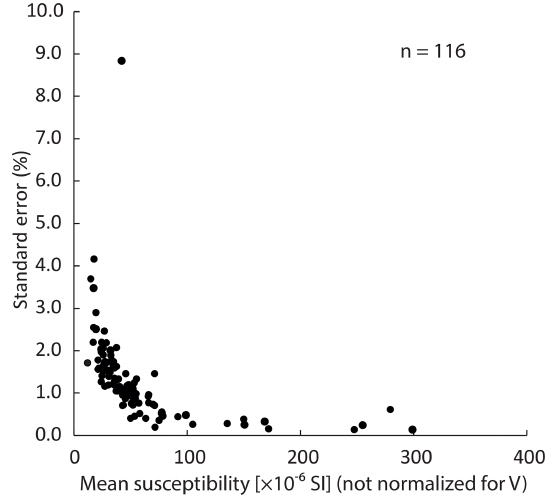
Figure 14. Standard error of the mean susceptibility (expressed in %) as a function of mean susceptibility (not normalized for